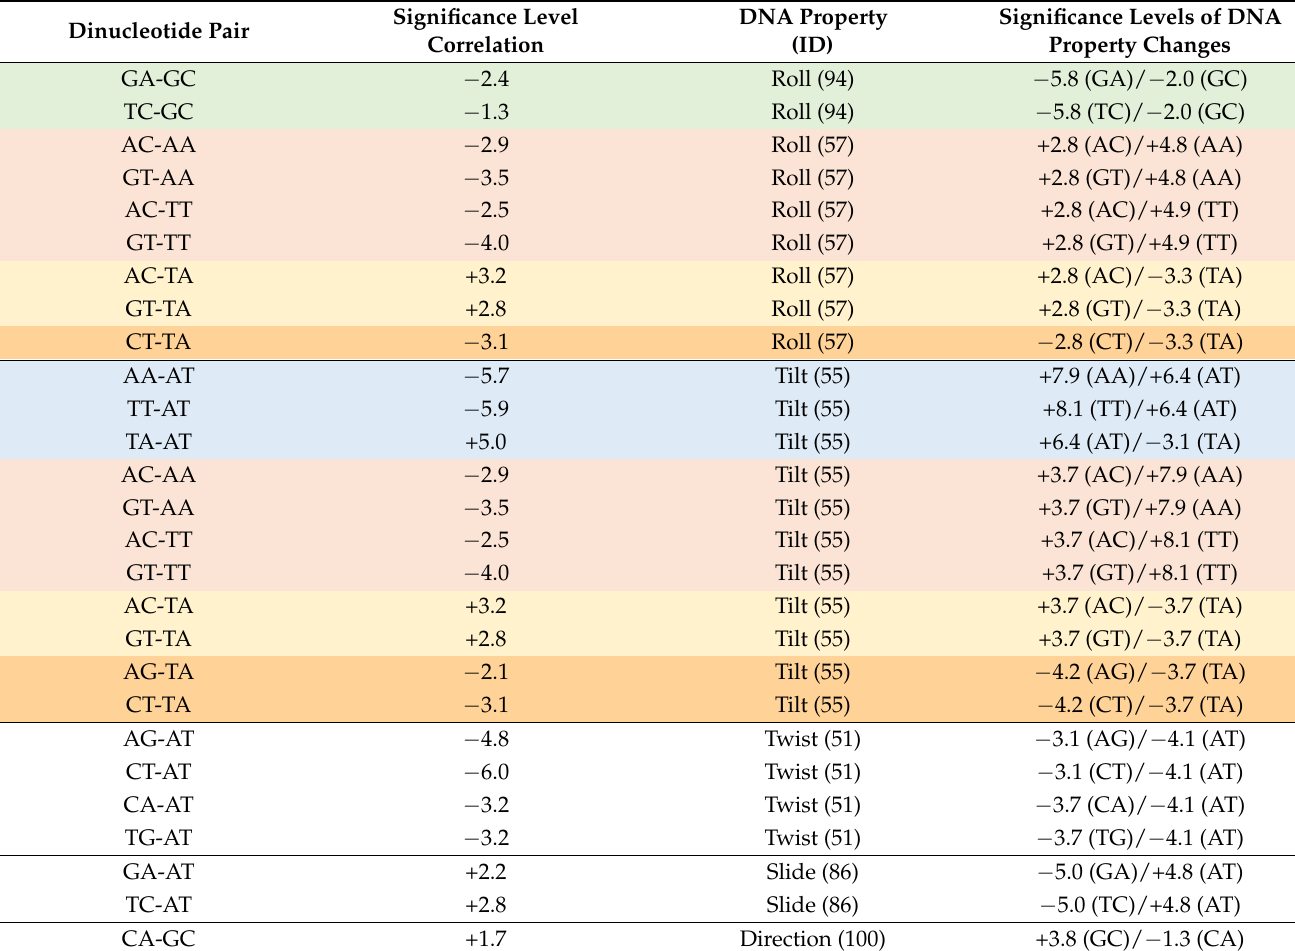
Table 4. Correlated dinucleotide pairs significantly influencing DNA properties, not explained by CDS. Dinucleotide pairs with significant correlation (positive sign of significance level) or significant anticorrelation (positive sign of significance level) and significantly changed DNA properties. The significance and sign of the influence of the respective dinucleotides are also listed. Only correlated pairs with opposite influences on DNA properties and anticorrelated pairs with the same influence on DNA properties that change respective properties by at least 10% are included. Rows representing interesting dinucleotide patterns are grouped and marked by different background colors. Green: pairs including a non-pure A/T dinucleotide and GC; Red: pairs including AC/GT with poly-A/T (always negative correlation). Orange: pairs including AG/CT (always negative correlation) with AT. Yellow: pairs including AC/GT (always positive correlation) with TA. Blue: pairs including AA/TT/TA with